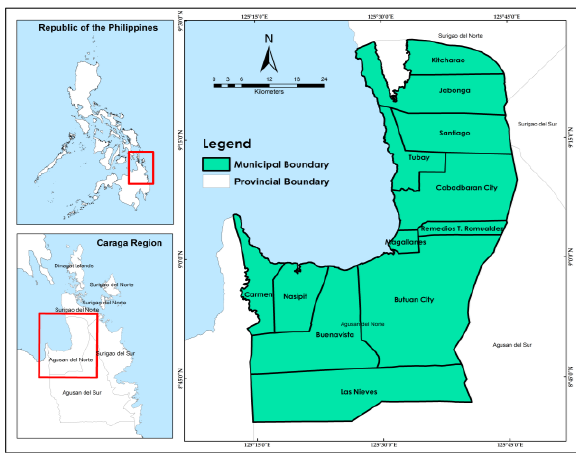
Figure 1. The Study Area: Agusan del Norte, Philippines.